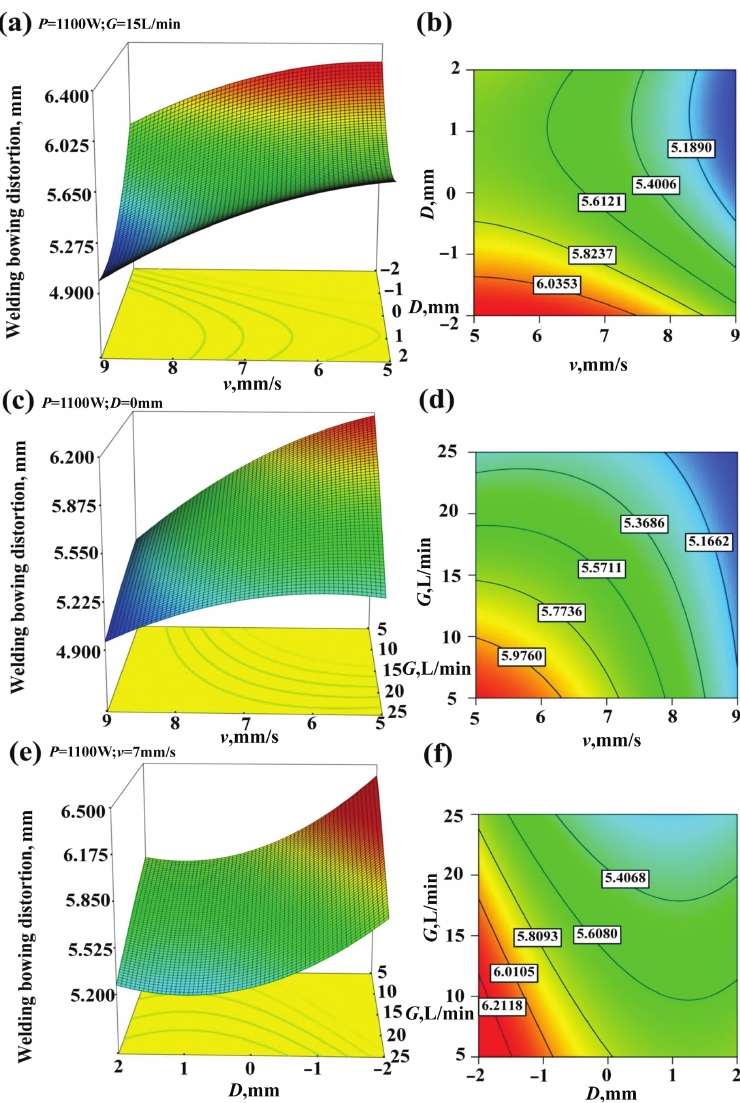
Figure 9: 3D response surface graphs and con- tour plots based on the quadratic model: (a), (c), (e) response surface graphs demonstrating the interaction effects of the welding speed, defo- cusing distance and gas flow rate; (b), (d), (f) contour plots of (a), (c), (e),